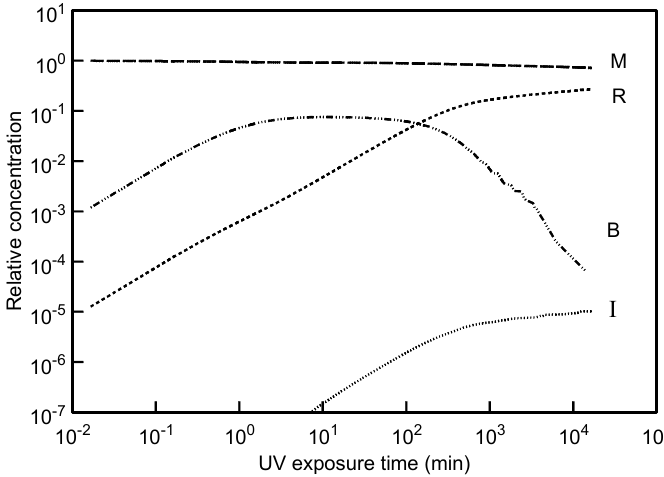
Figure 4. Modeled dynamics of DEH photo-oxidation with UV exposure for φ = 0.01, β =